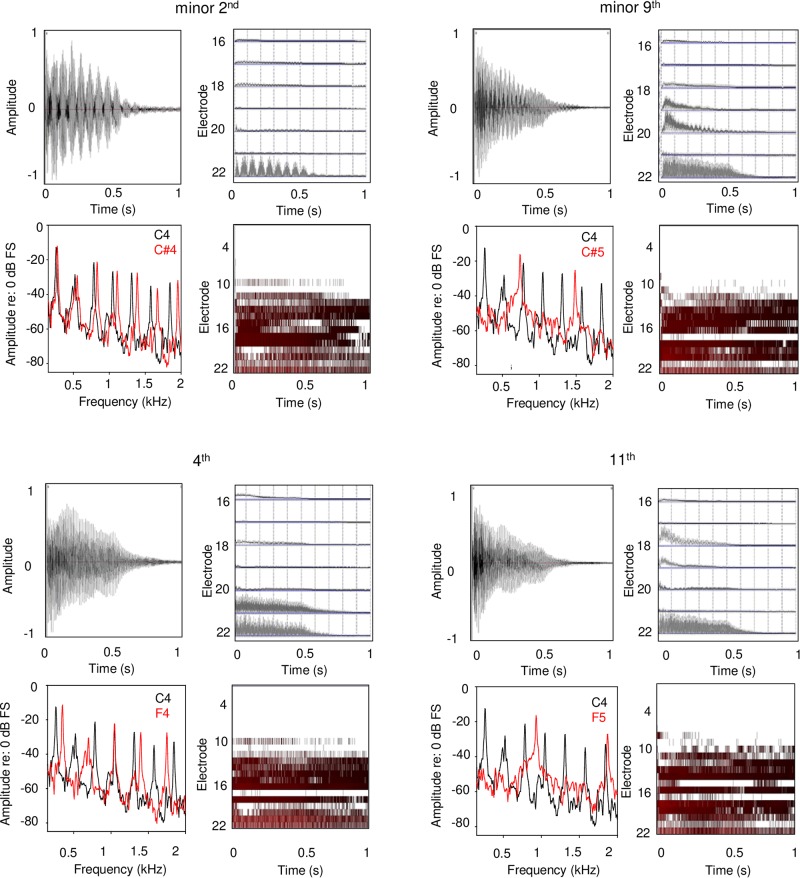
Waveforms, frequency analyses, extracted temporal envelopes, and electrodograms for example dissonant (top panels) and consonant intervals (bottom panels); the left and right panels show within- and across-octave intervals, respectively. The root note for all intervals was C4. Each panel shows (in clockwise order from the top left): waveform, temporal envelopes extracted from each CI signal processor analysis band, electrodogram, and frequency analysis. The extracted temporal envelopes and electrodograms were generated using custom software and using default parameters for Cochlear devices (e.g., ACE strategy, 8 maxima, 900 pulses/second stimulation rate, input frequency range 188–7938 Hz, etc.).